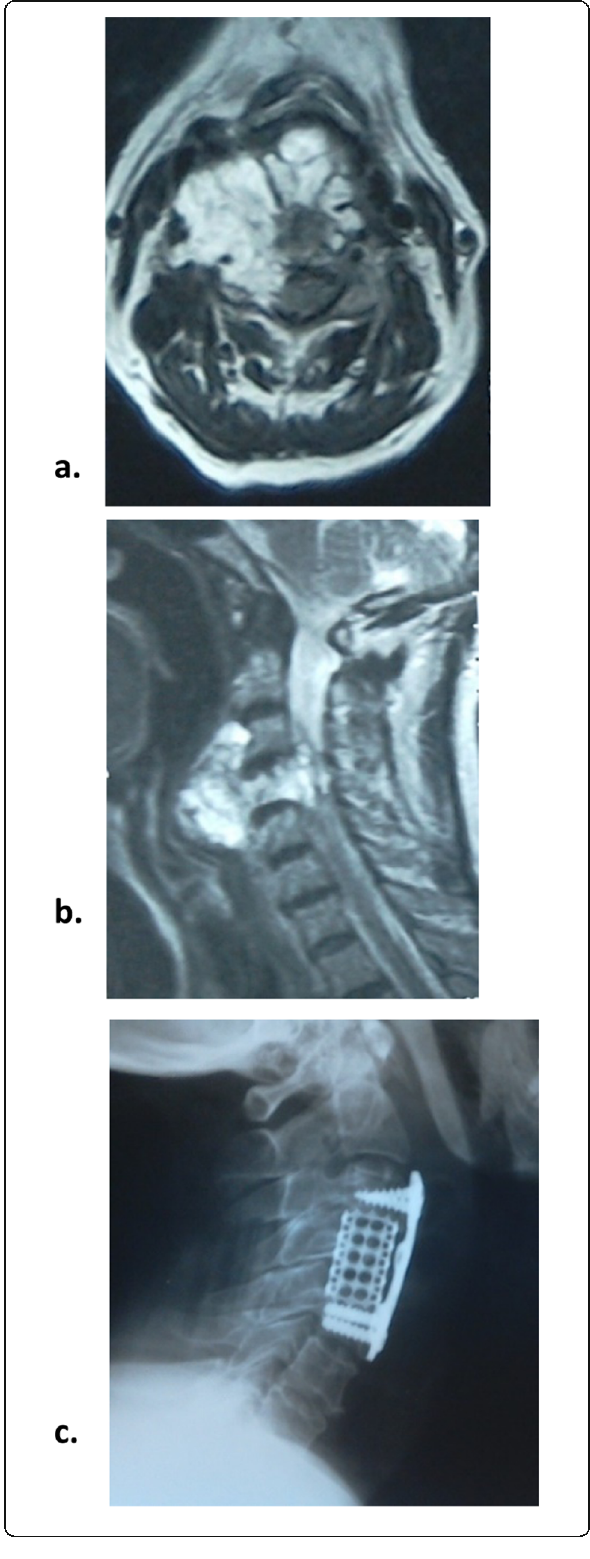
Fig. 1 Case 7. A 60-year-old woman with primary cervical chordoma. Axial ( a ) and sagittal ( b ) MRI scans reveal C-4 vertebral body destruction associated with a large soft tissue mass. c Cervical spine X-ray after anterior C-4 corpectomy and reconstruction (titanium mesh cage, locking plate and